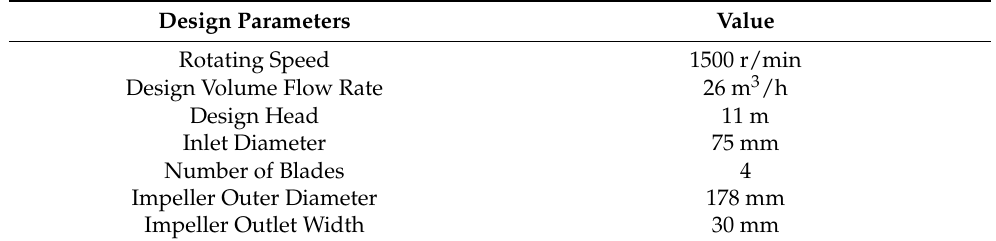
Table 1. Geometric specifications of the impeller.